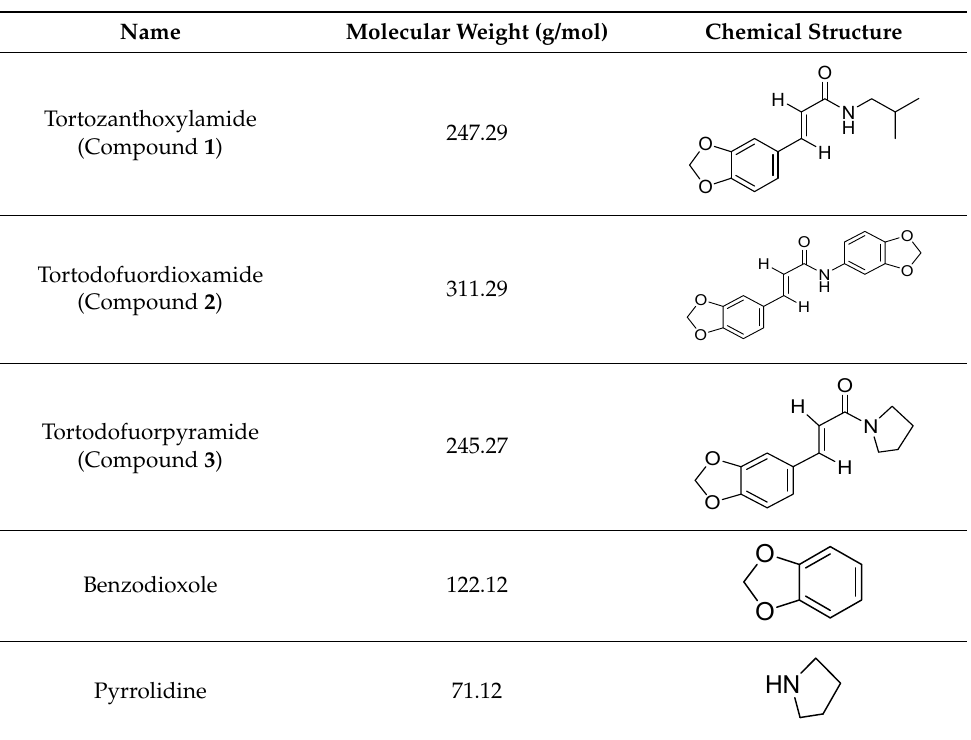
Table 1. Chemical structures and molecular weights of compounds and moieties.